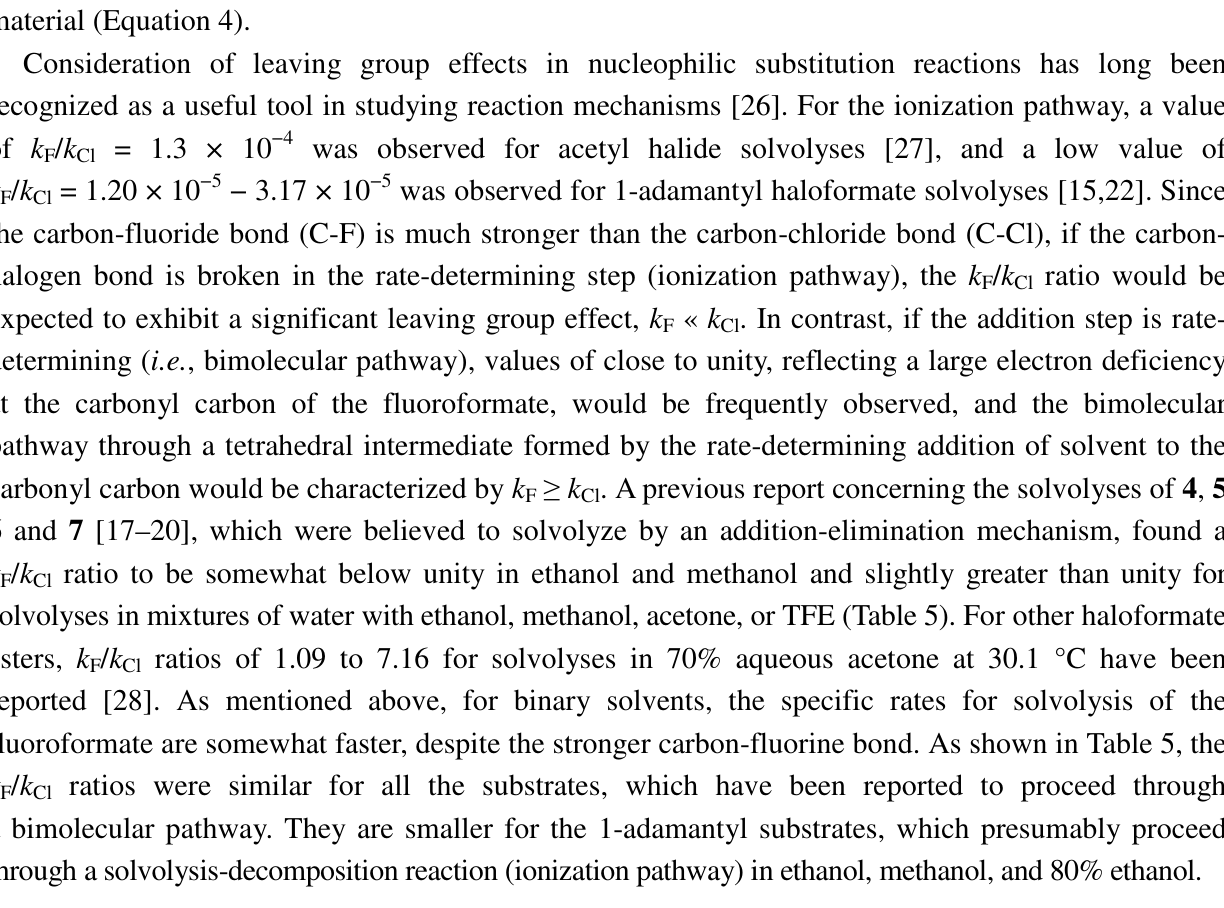
/k ) of solvolyses of alkyl haloformates in pure and F Cl